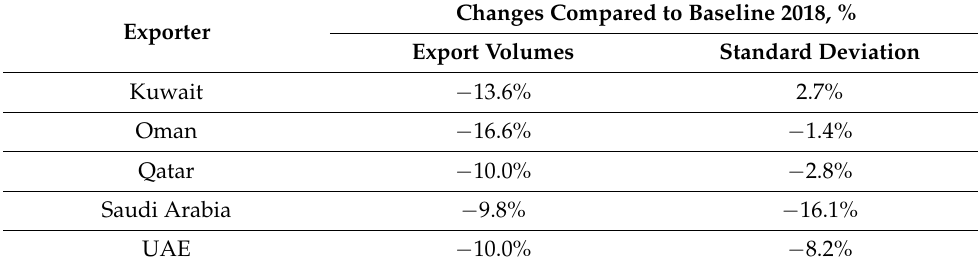
Table 8. Impacts of the Malacca Strait